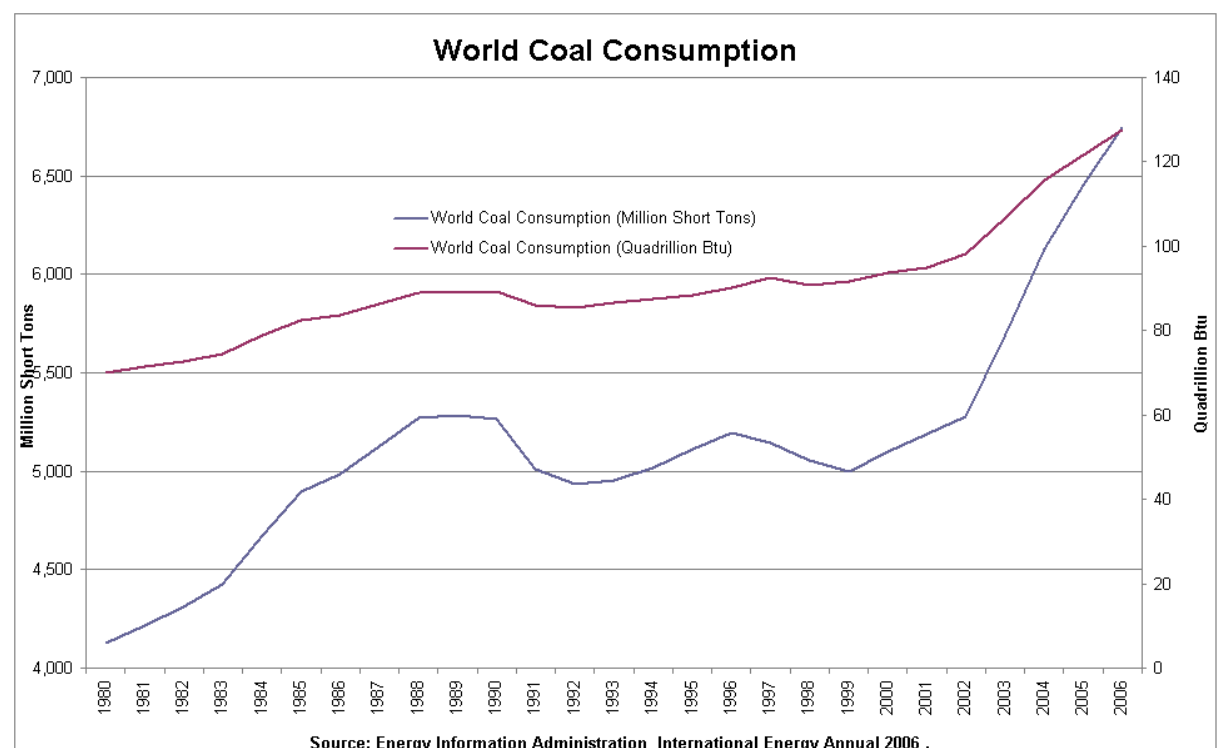
Figure 2. World consumption of coal. Source: